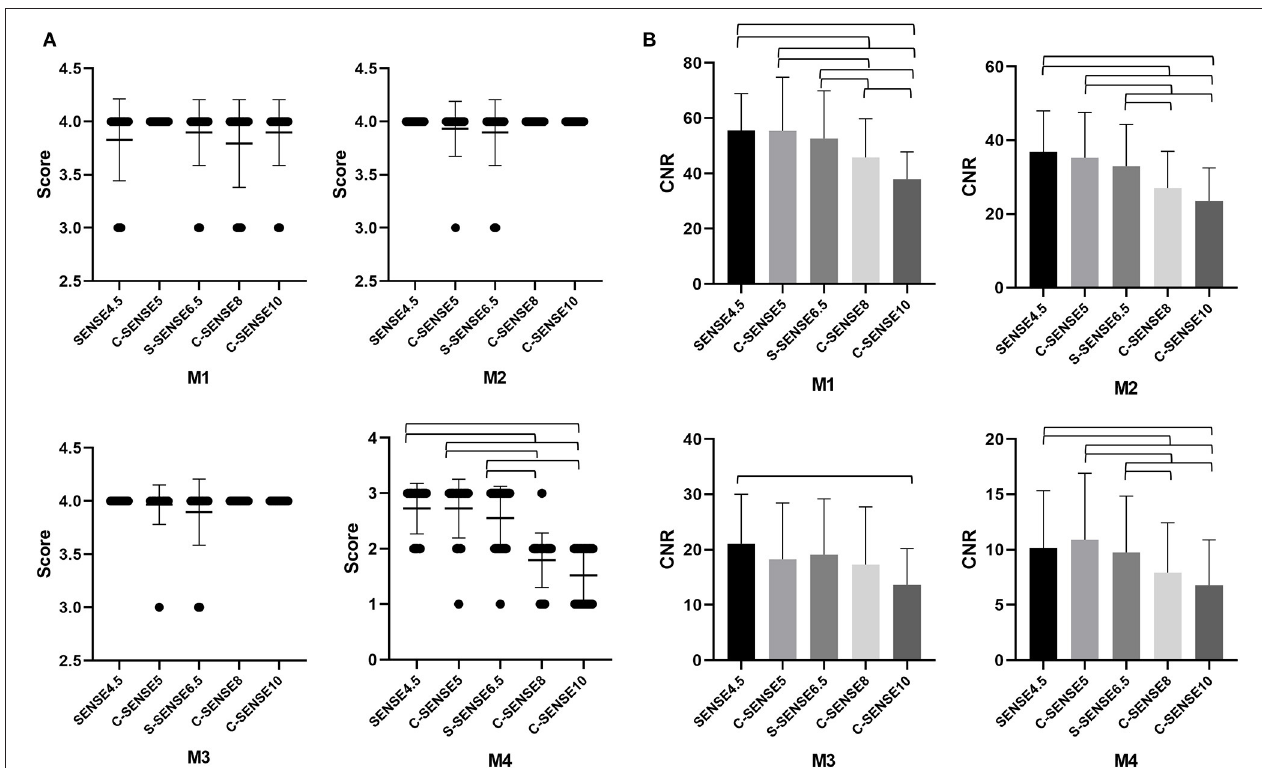
FIGURE 2 | (A,B) The mean vessel visualization scores and CNR of M1, M2, M3, and M4 segments of the MCA in images acquired by 4D-PACK with different accelerated factors. The error bars are the standard deviation of the regions of interest (ROIs). The parentheses indicate that vessel visualization scores or CNR in the two sequences are significantly different ( P < 0.05).